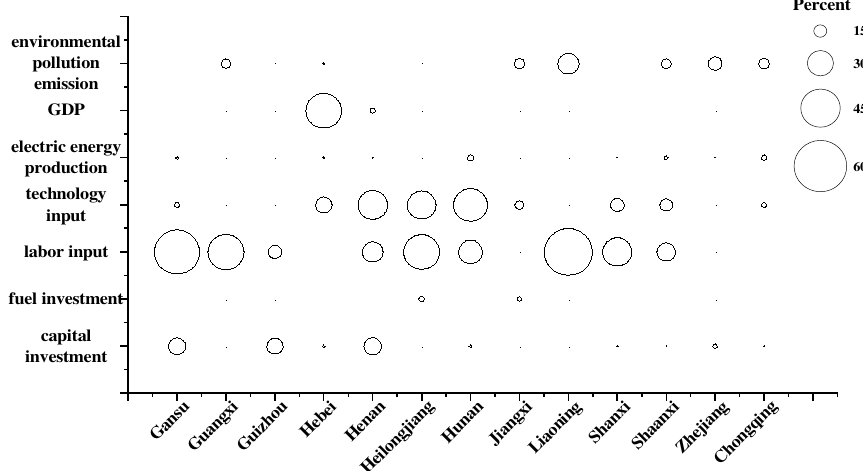
Figure 5. Percentage of improvement in inefficient provinces in the year 2019.